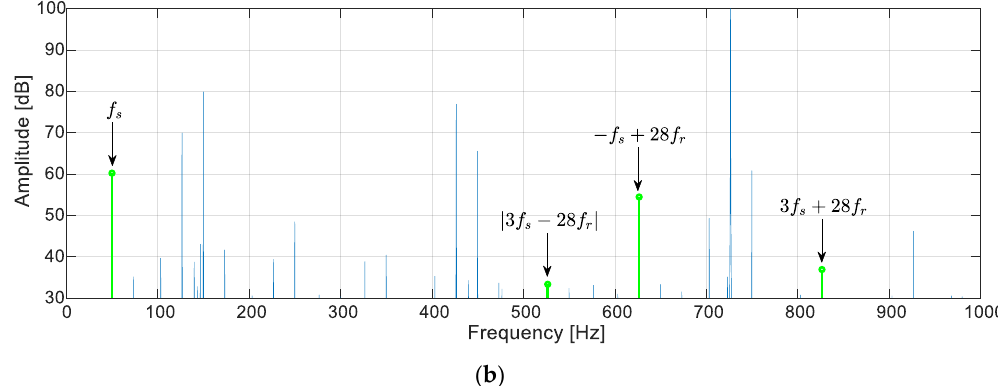
Figure 9. ZSC spectrum of motor with static eccentricity for the stator winding connections: ( a ) delta connection; ( b ) wye connection with neutral wire.